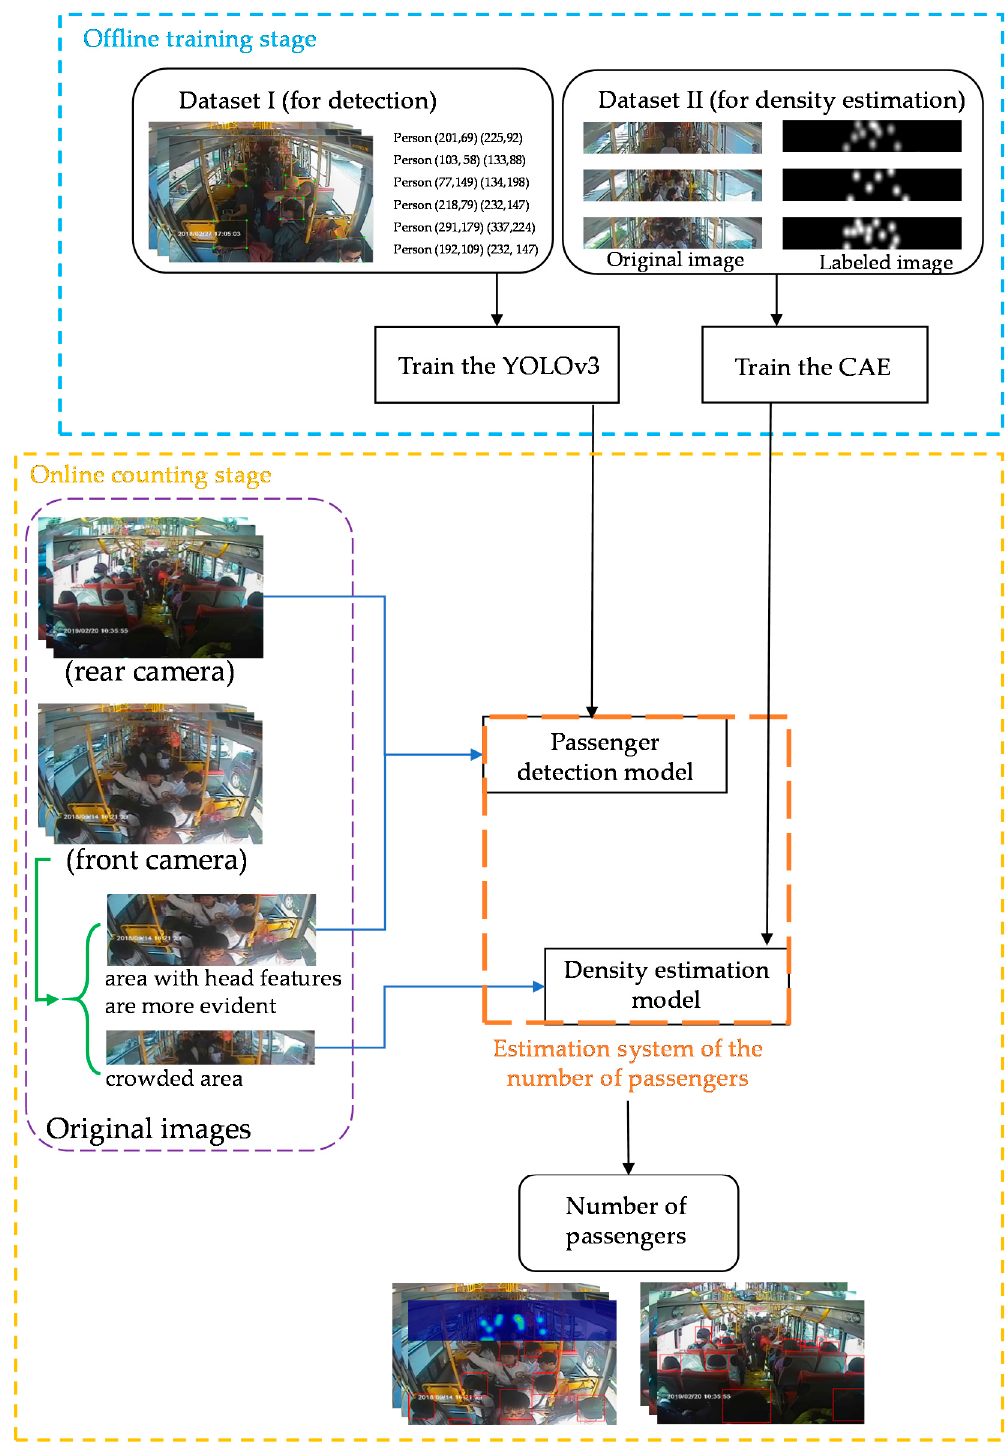
Figure 1. Flowchart for estimation of the number of passengers on a bus.